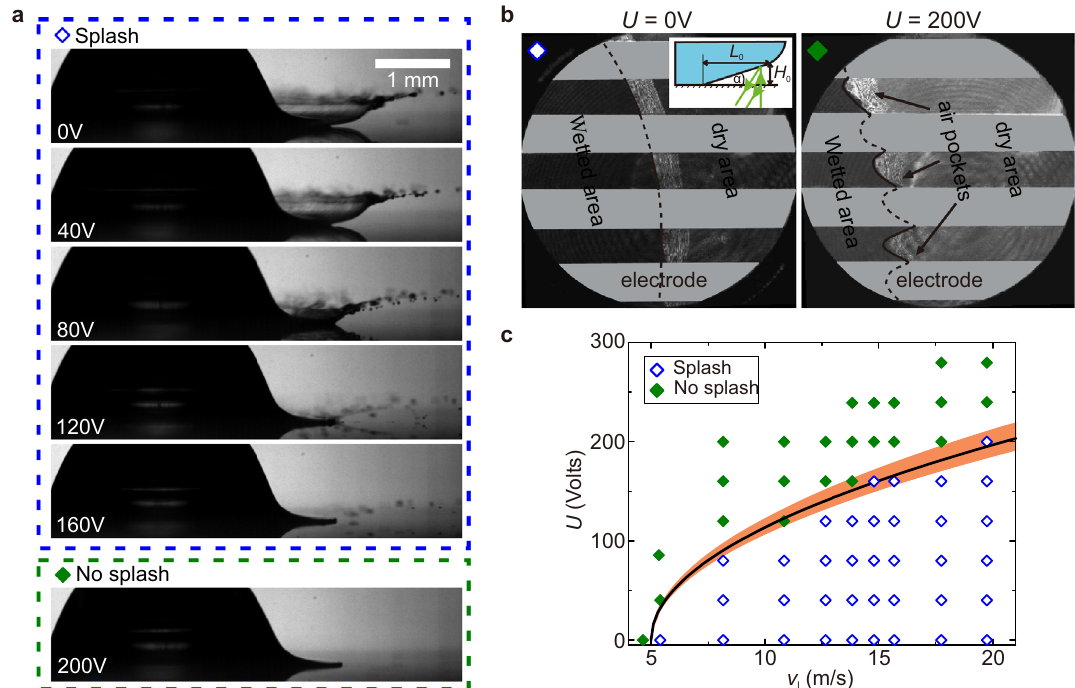
Fig. 4 Splash suppression using the periodic dielectrophoretic effect. a Snapshots showing progressive suppression of splash by increasing U from 0 to 160 V. Splash is completely eliminated at U = 200 V. The impacting droplets have R = 1.3 mm and v = 3.1 m s − 1 ; the snapshots are all taken at t = 0.3 ms after impact. b Bottom-view snapshots taken at t = 30 μ s after impacts of droplets with v = 2.5 m s − 1 for U = 0 V (left snapshot) and U = 200 V (right snapshot). Applying the voltage causes signi fi cant changes of the wetting front and the resulting air layer between the advancing lamella and the surface. In both snapshots, the wetting radius is ≈ 500 μ m. Inset: Schematic of the air wedge made by the spreading lamella and the substrate. The small wedge angle α allows formation of interference patterns in front of spreading lamellas. c Diagram showing a clear separation between splash and no-splash behaviours when varying the spreading velocity v l of the lamella and the applied voltage U . The solid line indicates the splash suppression condition U ¼ C (cid:2) 1 = 2 Φ ð v (cid:2) v Þ 1 = 2 , where C = 1.51. The shaded area indicates ±10% deviation from the theoretically predicted m l t are δ = 50 μ m (Fig. 1b). An insulating layer of silicon nitride (Si 3 N 4 ) of thickness 500 nm is deposited on top of the substrate and electrodes using plasma-enhanced chemical vapour deposition. The silicon nitride layer is covered by a 50-nm layer of fl uoropolymer (Te fl on, Dupont). The dielectrophoretic effect is induced by applying a DC voltage varying from 0 to 400 V to the electrode terminals, which are connected to the pair of interdigital electrodes. The needle used to dispense droplets is grounded to ensure negligible initial potential for impacting droplets. High-speed imaging experiment . The interactions between impacting droplets and the solid surface are observed from the bottom view using two interferometric set- ups: set-up 1 is used to capture snapshots with high spatial resolutions, both in horizontal and vertical directions, and set-up 2 is used to track the fast evolution of the air layer pro fi les. In set-up 1, we use a high-speed camera (SAX2, Photron Inc.) illuminated by a dual-pulse laser (Nd:YLF DualPower TR, Dantec Dynamics Inc.) with 4 ns pulse width. In this set-up, the coherence length of the laser is ≈ 10 mm, suf fi ciently large